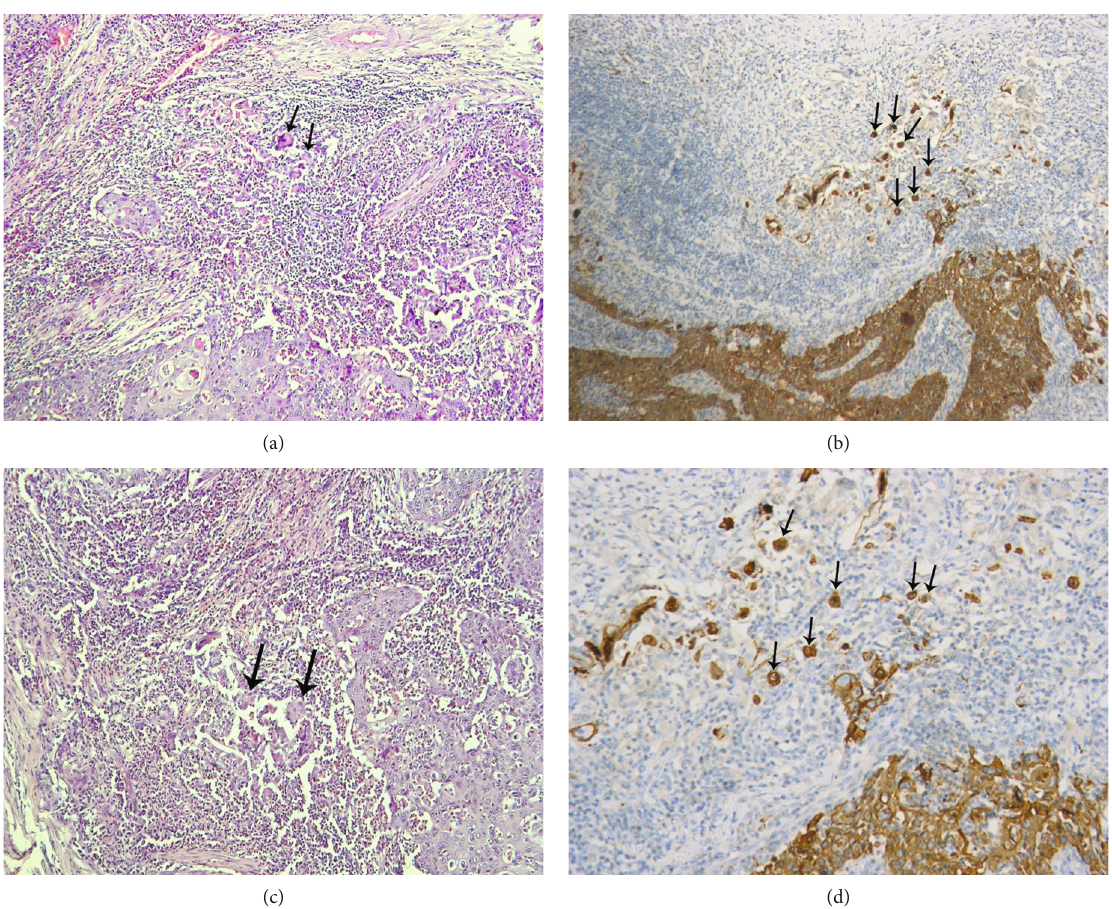
Figure 2: Tumor budding obscured by extensive in fl ammation and reactive stromal cells: (a) by H&E (H&E, × 100), (b) by pancytokeratin (IHC, × 100), (c) by H&E (H&E, × 100), (d) by pancytokeratin (IHC, × 200). Black arrows are showing examples of the tumor